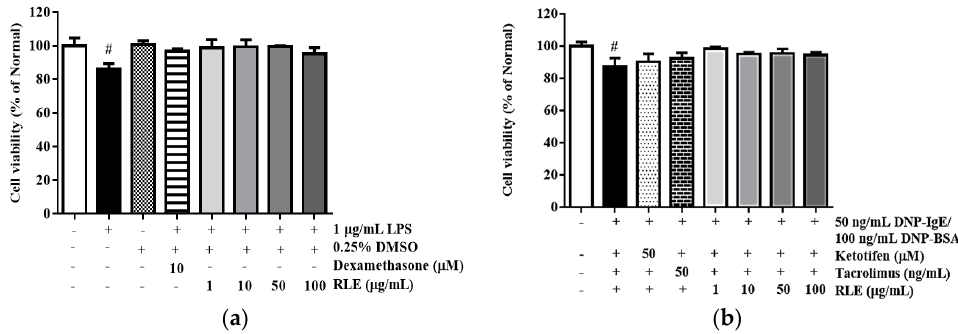
Figure 3. The cytotoxicity of R. davurica Pall. leaf extract on RAW 264.7 cells ( a ) and RBL − 2H3 cells ( b ). Data are presented as the mean ± SD. # indicates significant differences from the non ‐ treated cells. # p < 0.05 vs. the non ‐ treated group.